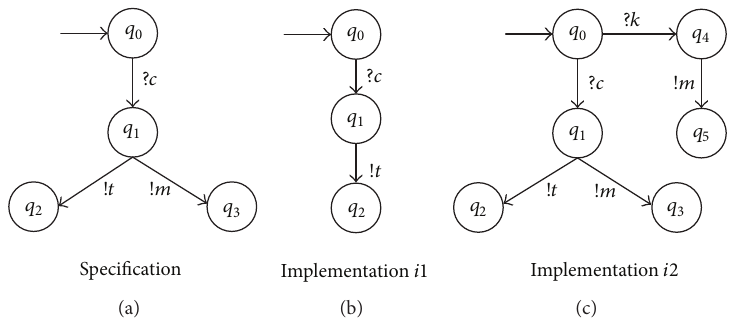
Figure 2: The specification and implementation IOLTS models for the AVM software.